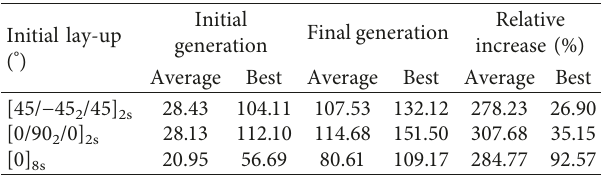
Table 4: Objective values of initial and final generations in first phase optimization for Shell 1